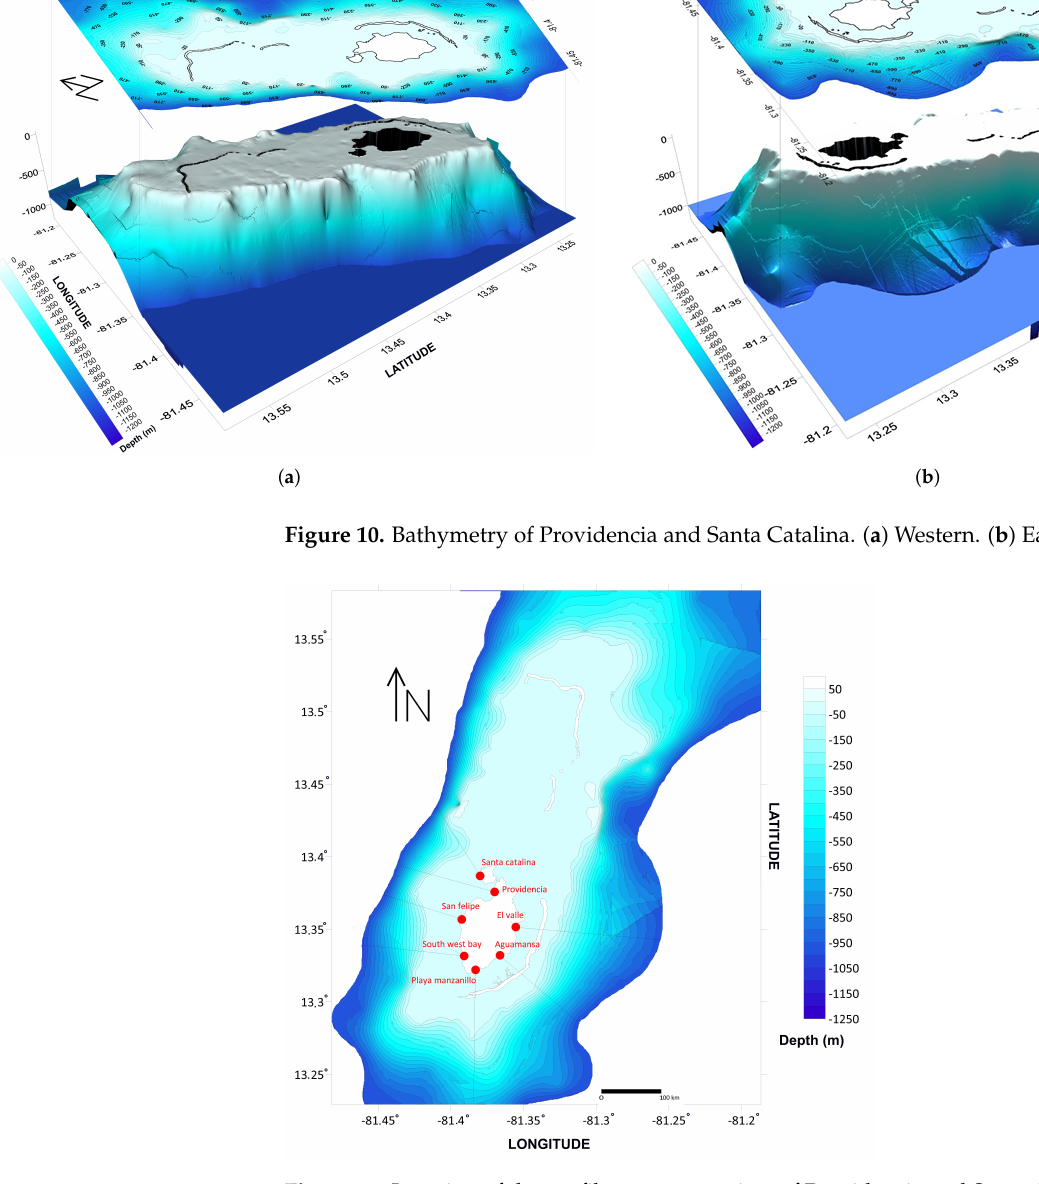
Figure 11. Location of the profiles at seven points of Providencia and Santa Catalina.